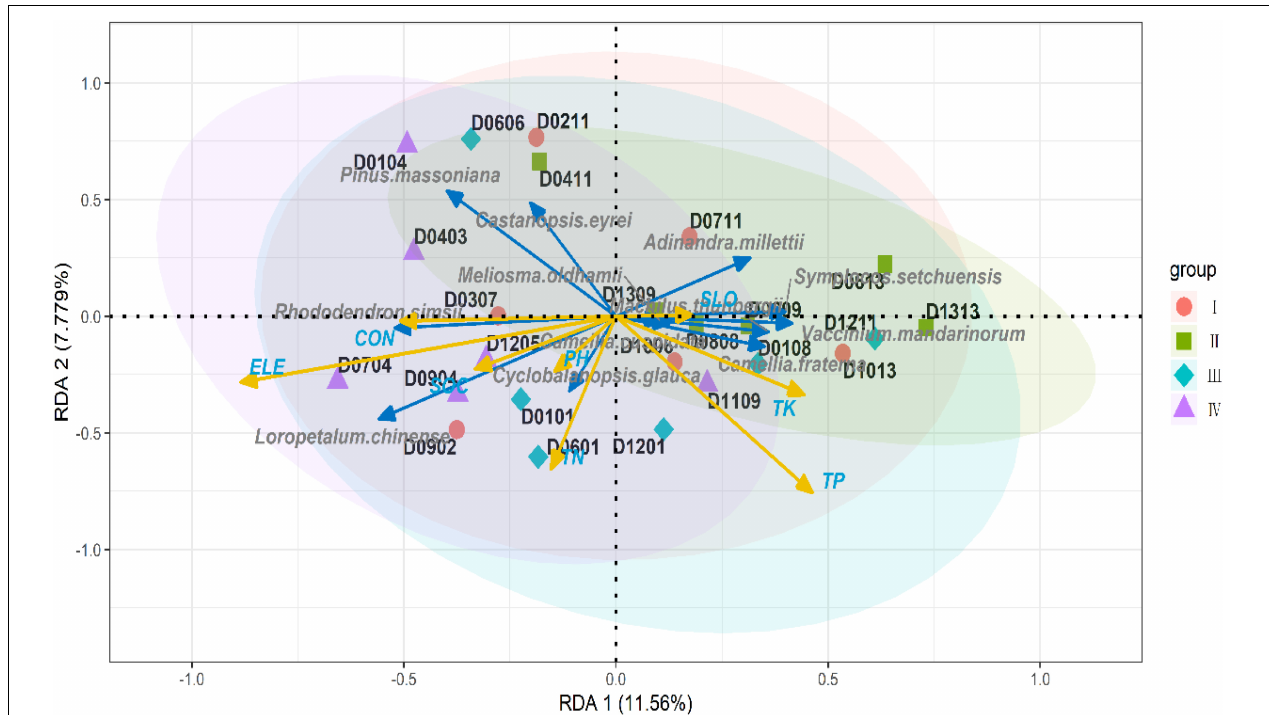
FIGURE 4 | Redundancy analysis (RDA) ordination plot for the multivariate effects of soil properties and topography. The blue arrow is the response variable and the yellow arrow is the explanatory variable. The shaded area indicates the confidence interval for each component (ELE, elevation; CON, convexity; SLO, slope).